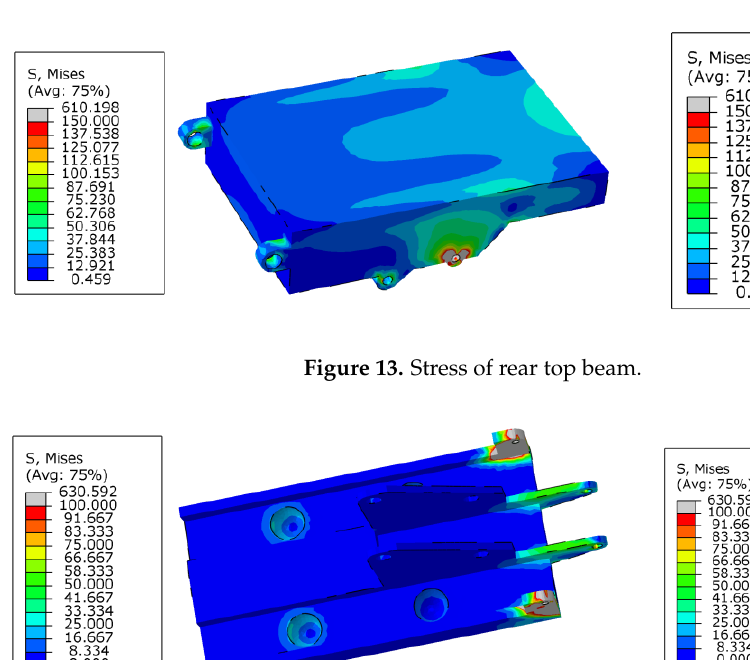
Figure 12. Stress of top beam.